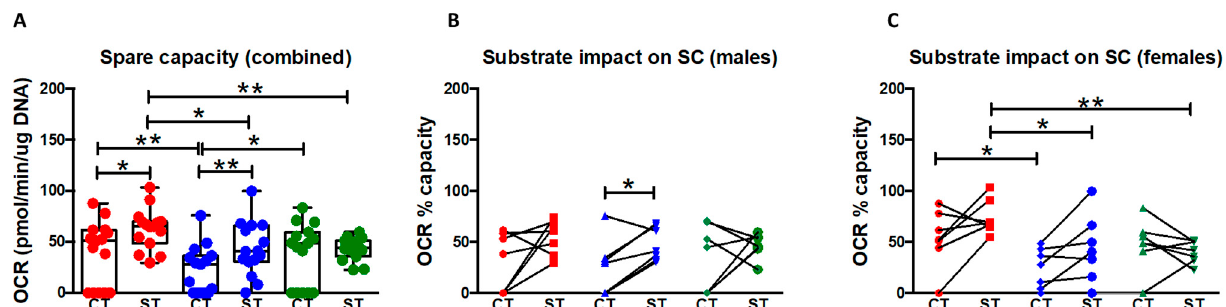
Figure 5. Impact of specific substrates on spare capacity of CT vs. ST. ( A ) Impact of glucose (red), glutamine (blue), and long chain fatty acid (green) on spare capacity for each fuel source with fetal sex groups combined ( n = 16). Combined data presented as minimum, maximum, median, 25th and 75th quartiles boxes, and whisker plots. * p < 0.05, ** p < 0.01, (Friedman test when comparing substrates or Wilcoxon test when comparing CT vs. ST). ( B ) Substrate impact on spare capacity in males ( n = 8), and ( C ) females ( n = 8). Glucose (red), glutamine (blue), and long-chain fatty acid (green). Data plotted as individual values of paired CT and ST from the same sample. * p < 0.05, (Friedman test when comparing substrates or the Wilcoxon test when comparing CT vs. ST).